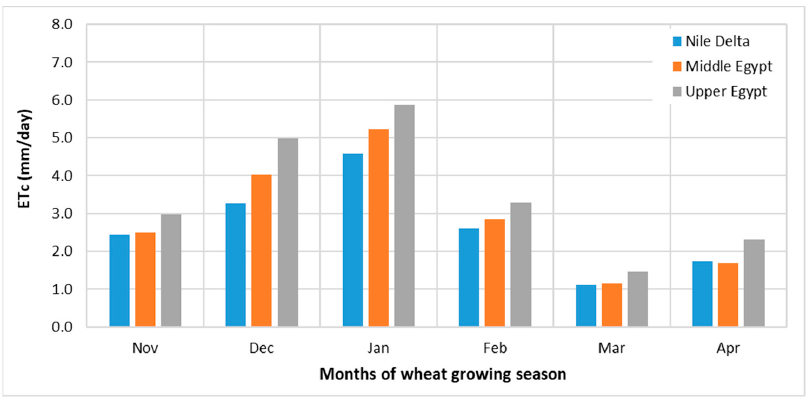
Figure 4. Wheat crop evapotranspiration for the three agro-ecological zones as the mean of a five-year period from 2015 to 2019.